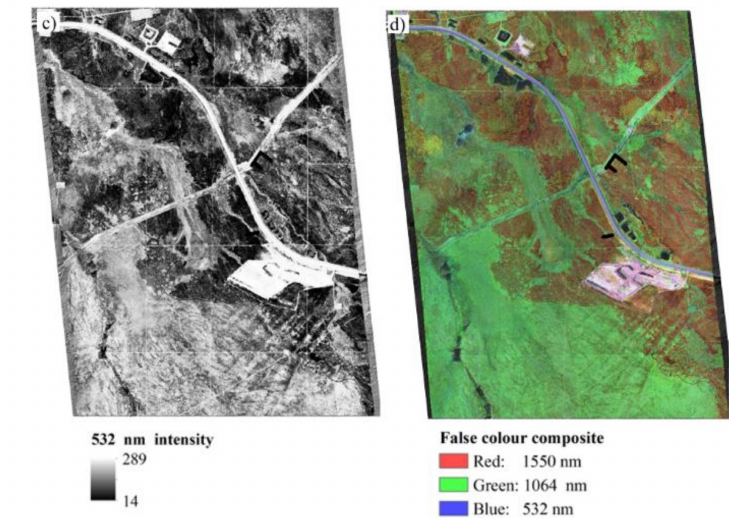
Figure 5. Gridded laser return intensities for burned and unburned boreal forest / peatland environment, where ( a ) is 1550 nm (channel 1), ( b ) is 1064 nm (channel 2), ( c ) is 532 nm (channel 3) and ( d ) is a false colour composite of the intensity images within red, green and blue colour bands. Red represents the area burned by wildfire, whereas green represents healthy vegetation (mostly forest and some